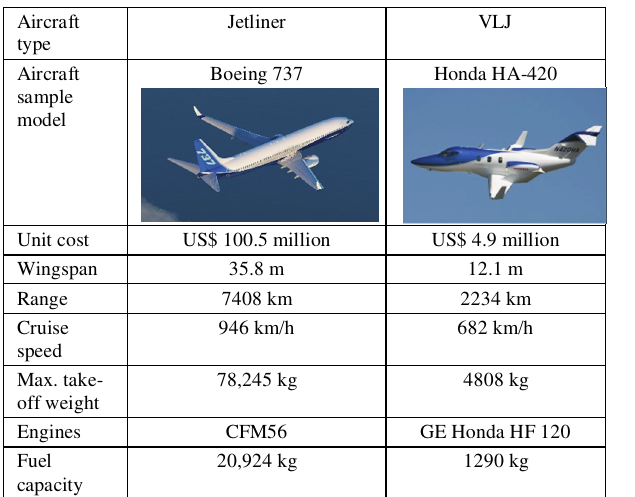
Table 2. The comparison of two sample aircrafts [15, 16]